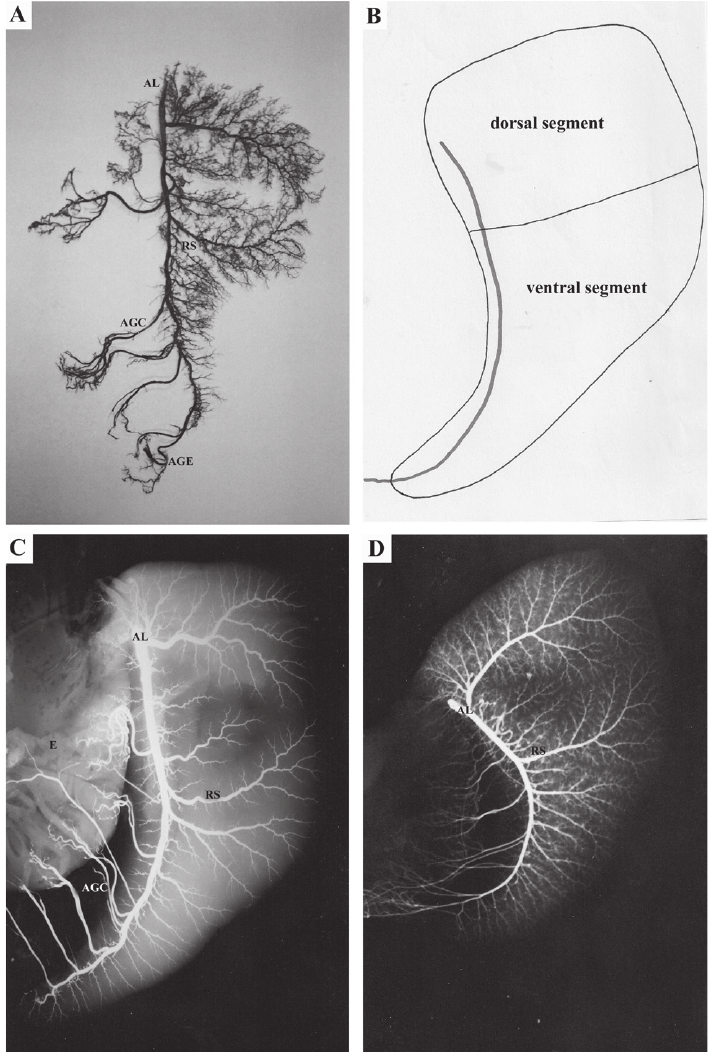
Figure 2 - A- Model of vinyl resin arterial vascularization of the spleen, where we can observe the lienal artery (AL), short gastric artery (AGC), left gastroepiploic artery (AGE) and the segmentary branches (RS). B- Schematic drawing showing the organ division in two anatomo-surgical segments based on distribution of segmentary branches. C- Digital image of arteriogram from equine spleen adult male showing the distribution of segmentary branches, 26 branches in intestinal face and 25 in gastric. We note the absence of conspicuous branches on the parenchyma in gastric face. Lienal artery (A.L.), short gastric artery (A.G.C.), segmentary branches (r.s.) and stomach (e). D- Digital image of arteriogram from spleen fetus male, at term, showing the distribution of segmentary branches, with 21 in intestinal and 25 in gastric face and, as in adults we noticed the lack of conspicuous branches on the parenchyma of gastric face. Lienal artery (A.L.) and segmentary branches